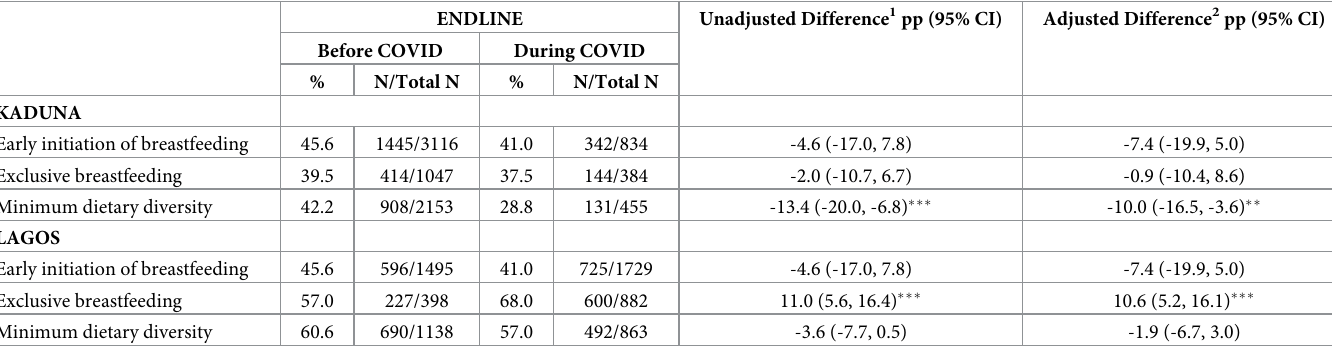
Table 5. COVID endline sensitivity analysis for IYCF practices, by